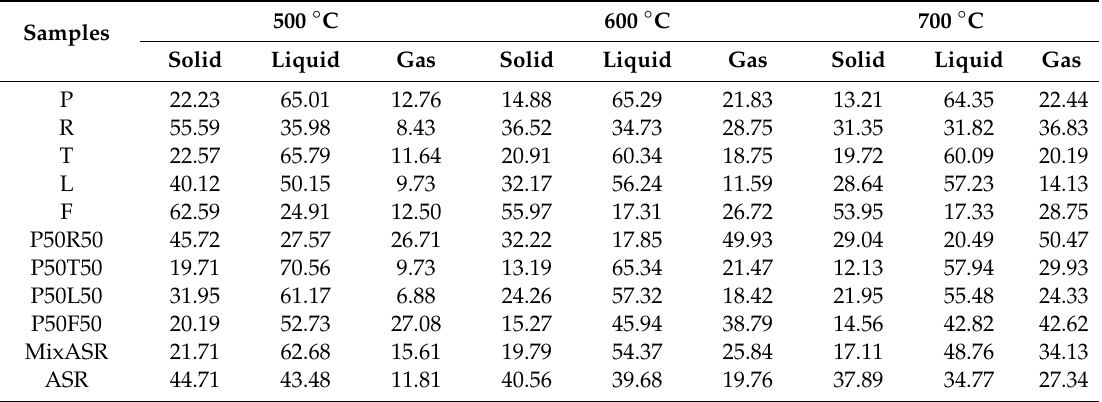
Table 4. Distribution of pyrolytic products of di ff erent samples at di ff erent finished temperature. 500 ◦ C Samples Solid Liquid Gas Solid Liquid